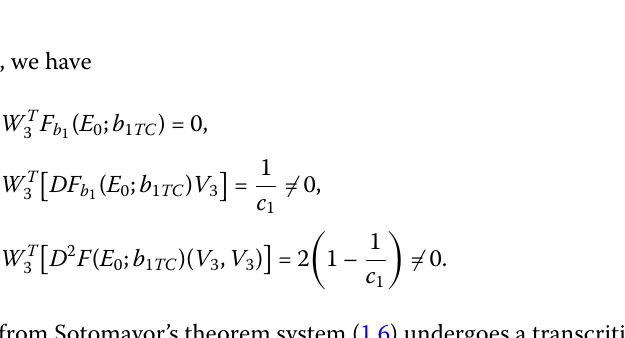
Figure 8 The phase portraits of transcritical bifurcation of system (1.6) around E